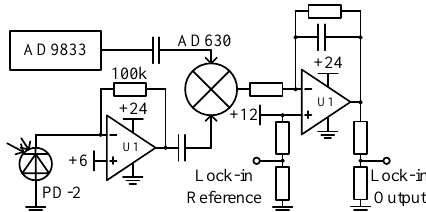
Figure 10. The circuits of the lock-in